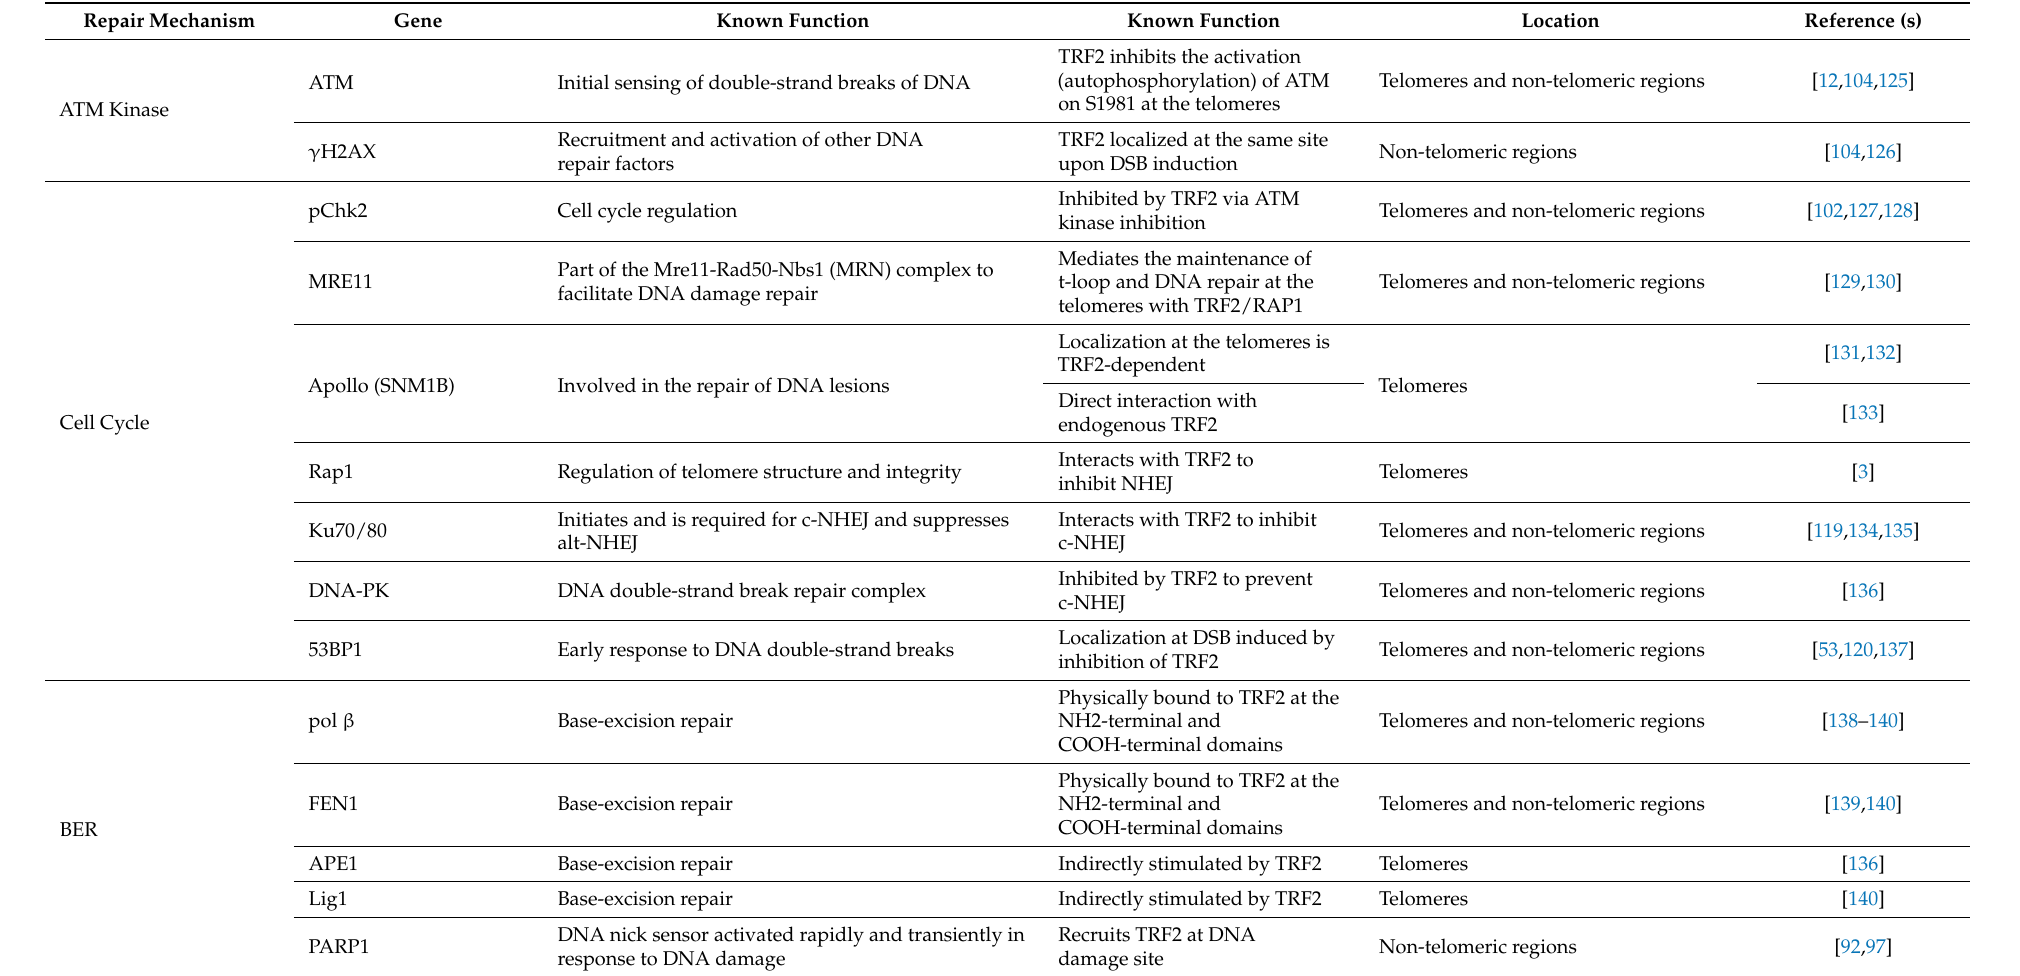
Table 2. DNA damage response factors that interact with TRF2 at the telomeric and non-telomeric